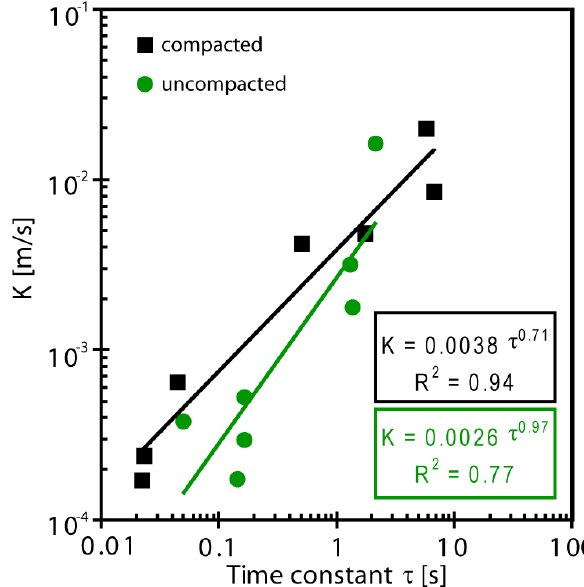
Cole relaxation time τ for compacted and uncompacted, unsieved, samples measured at ∼ 300µS/cm electrical conductivities of the saturating pore